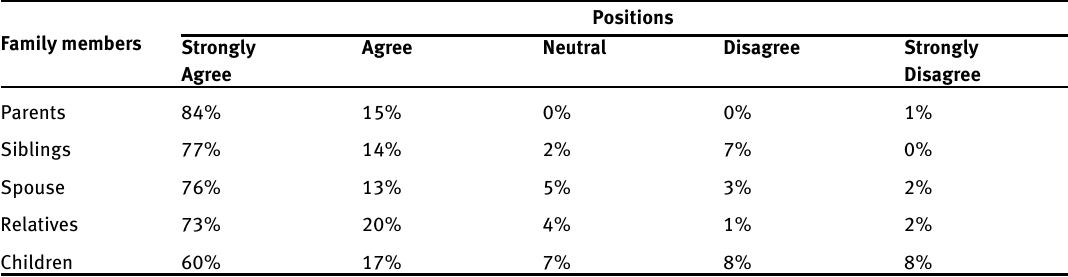
Table 2 . Positions towards language use in family conversations Family